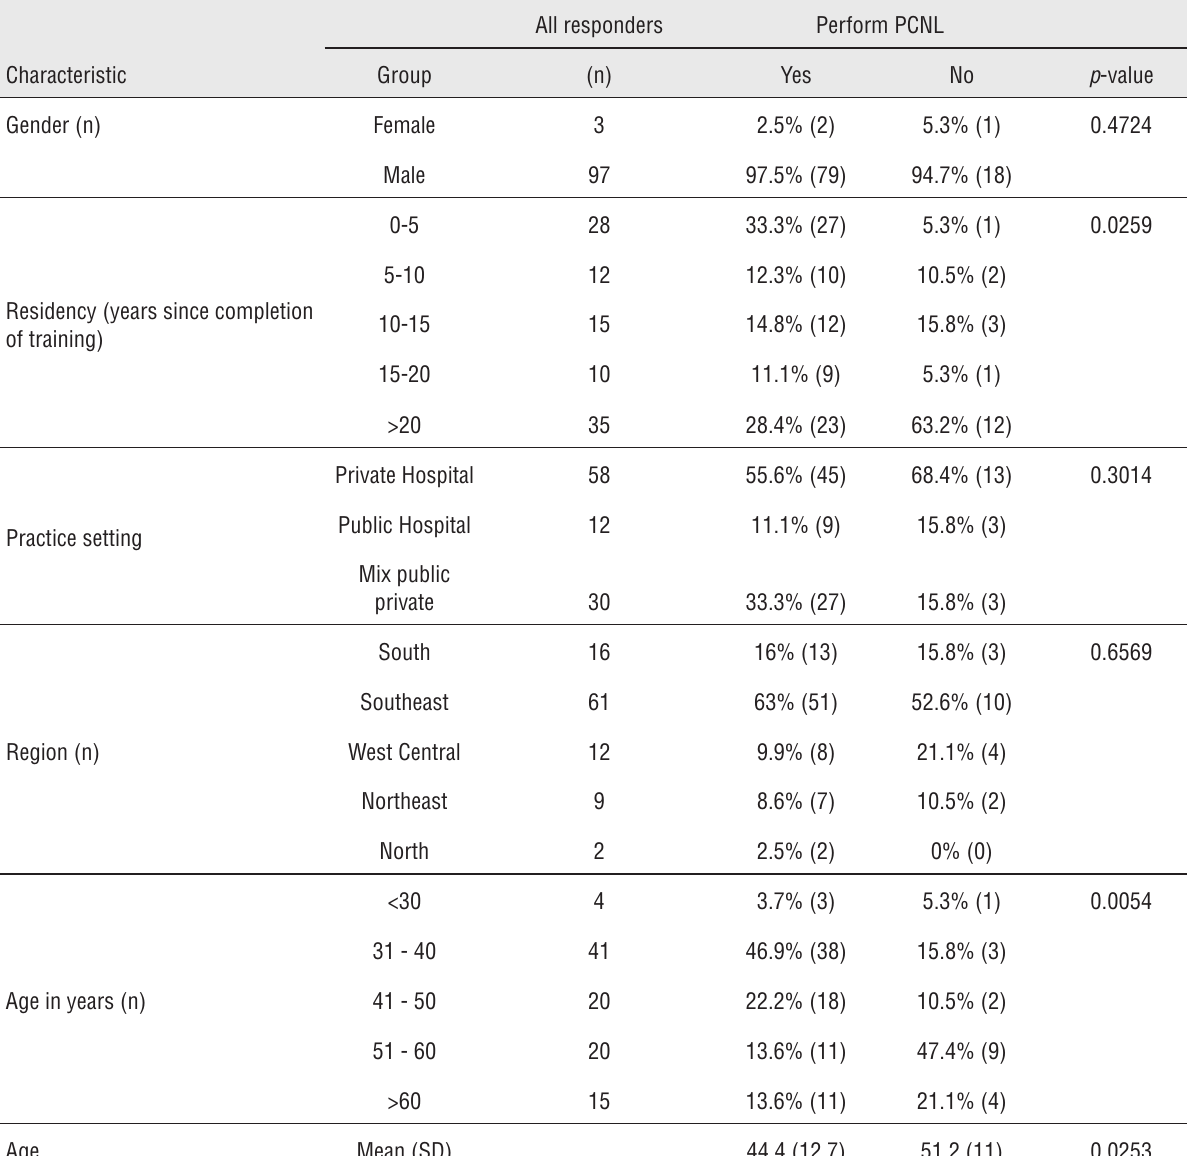
Table 2 - Patient demographics (all responders), performers and